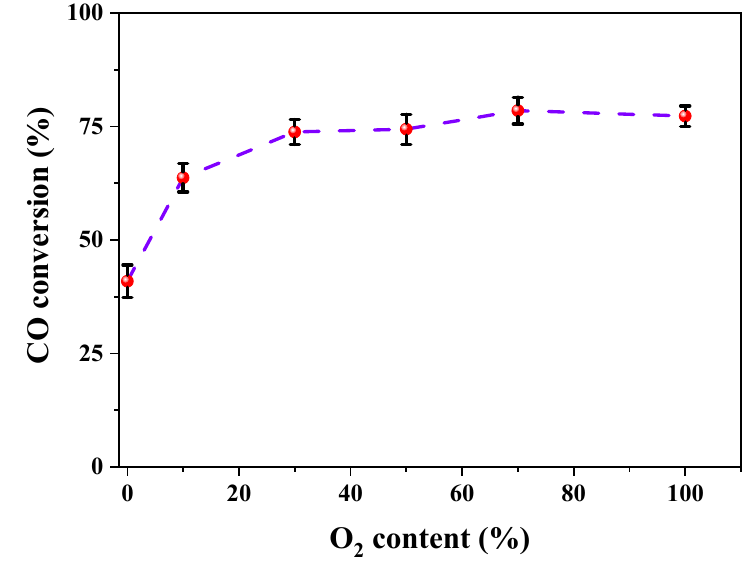
Figure 4. Effect of O 2 contents in O 2 /Ar discharge gas on CO conversion.